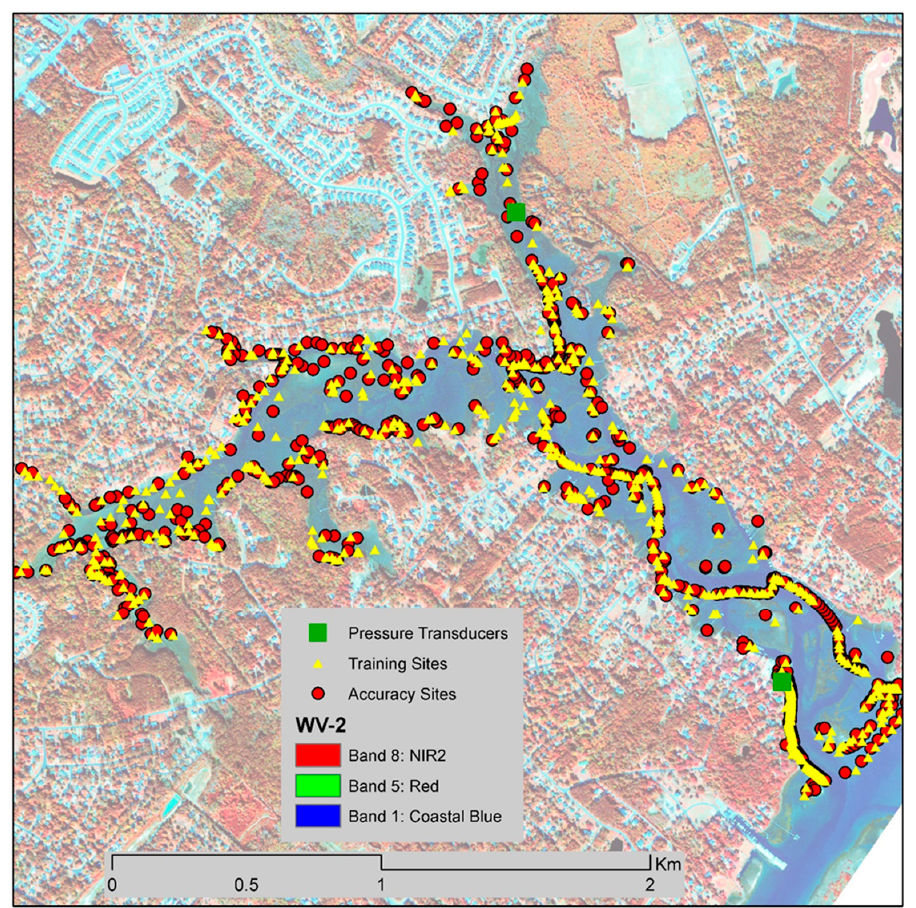
Figure 3. Location of pressure transducer gauges and ground reference points (GRPs). Half of the GRPs were used for image classification (training sites) and the other half were for classification accuracy assessment.